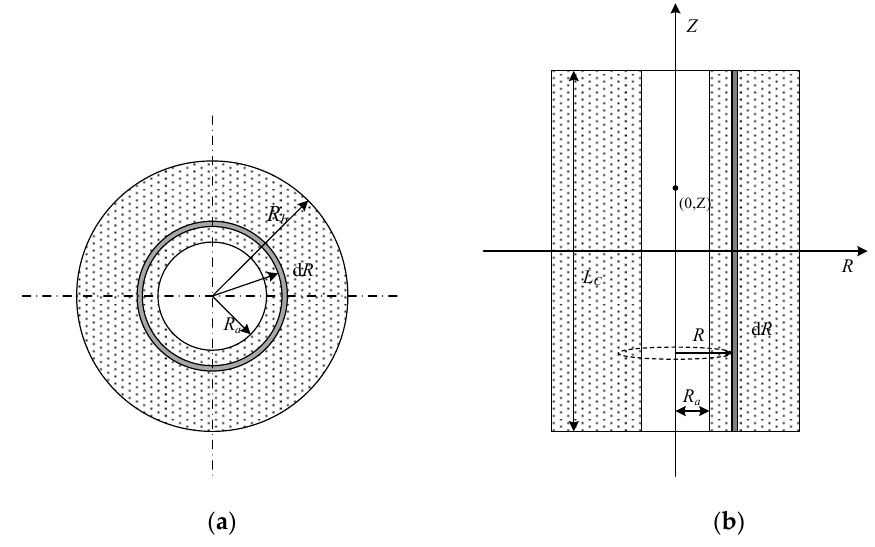
Figure 3. Coil skeleton: ( a ) Top view, ( b ) front view.